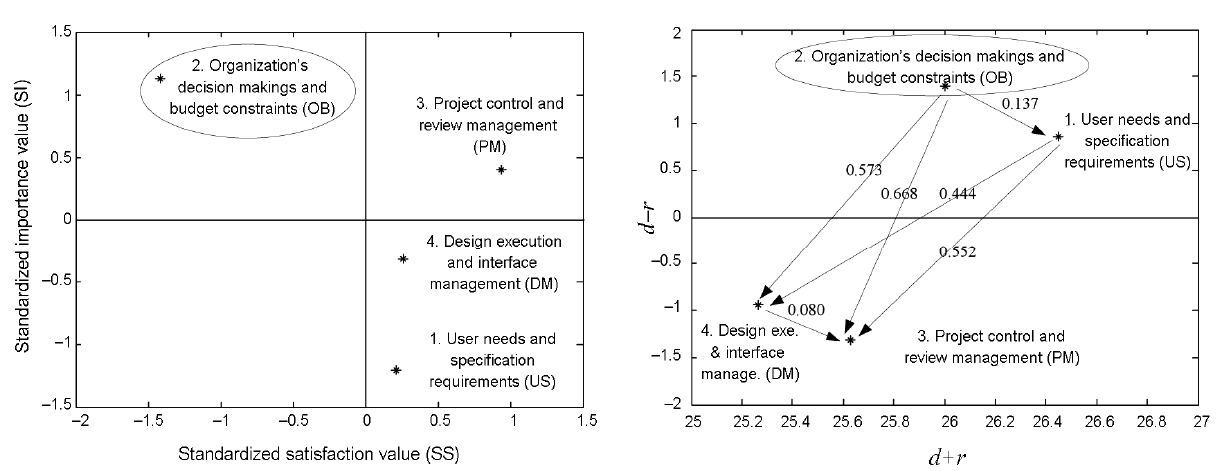
Fig. 5. Integration of ISA and IRM for first-level